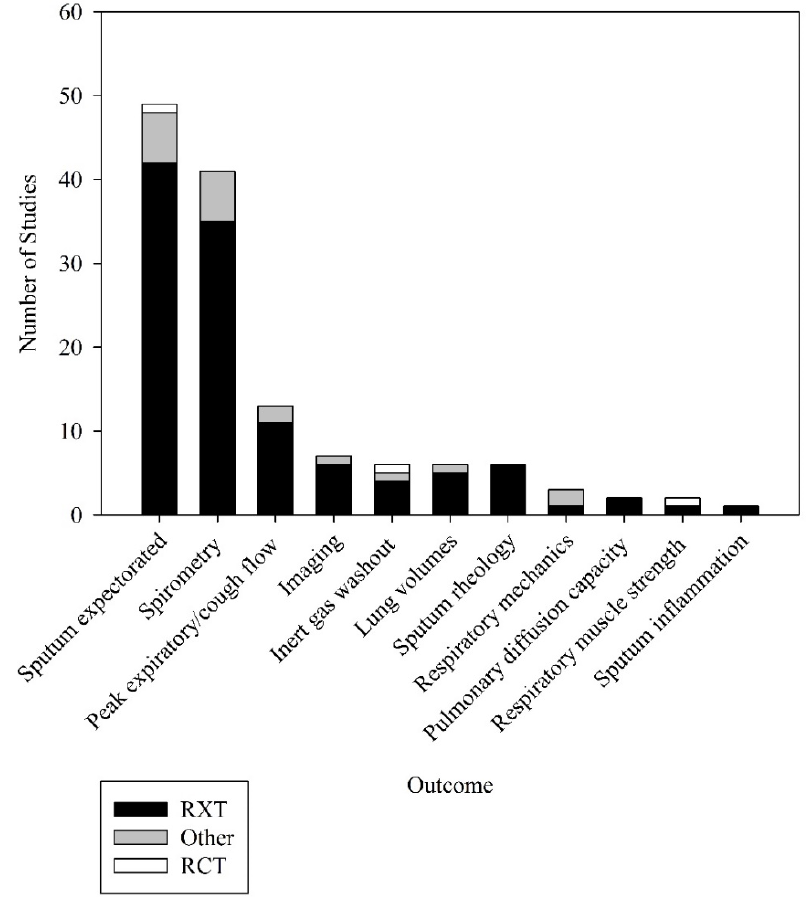
Figure 2. Objective outcomes used to measure effectiveness of airway clearance techniques. Other = other study designs apart from RXT and RCT; RCT = randomised controlled trials; RXT = randomised crossover trials.